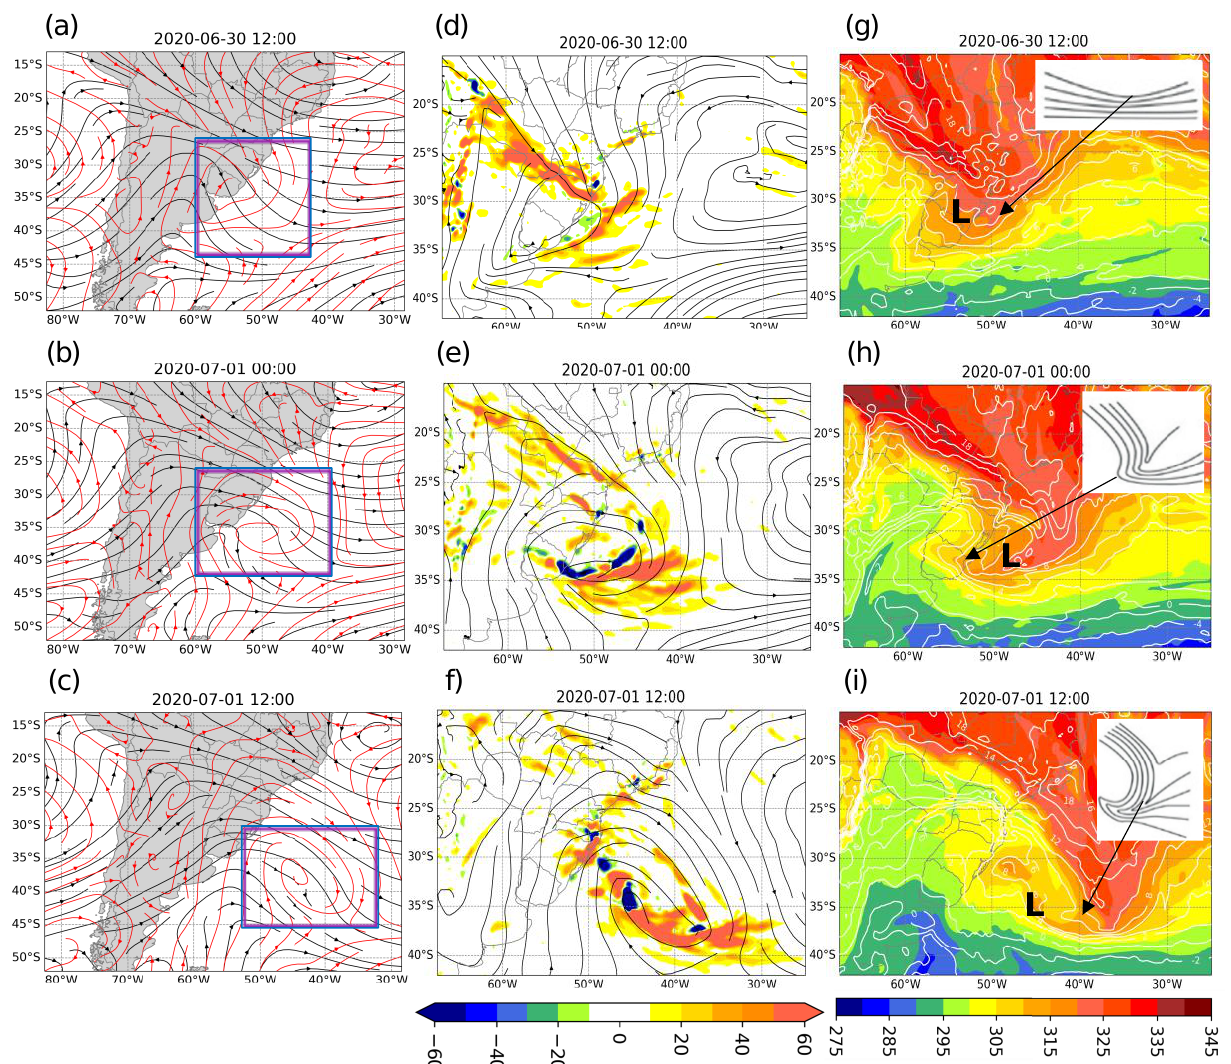
Figure 5. ( a – c ) Streamlines at 850 hPa (red) and at 250 hPa (black); blue box indicates the region with diffluent flow, ( d – f ) frontogenetic function at 850 hPa ( × 10 − 10 K m − 1 s − 1 ; shaded) and streamlines at 850 hPa (black), and ( g – i ) equivalent potential temperature (K, shaded) and air temperature ( ◦ C, white lines) at 850 hPa. In ( g – i ), (i–iii) shows a snapshot of the extratropical cyclone stages following the Bjerknes and Solberg conceptual model. The low position based on MSLP is indicated by L; the colored lines indicate the cold (dark blue) and warm (dark red) fronts.